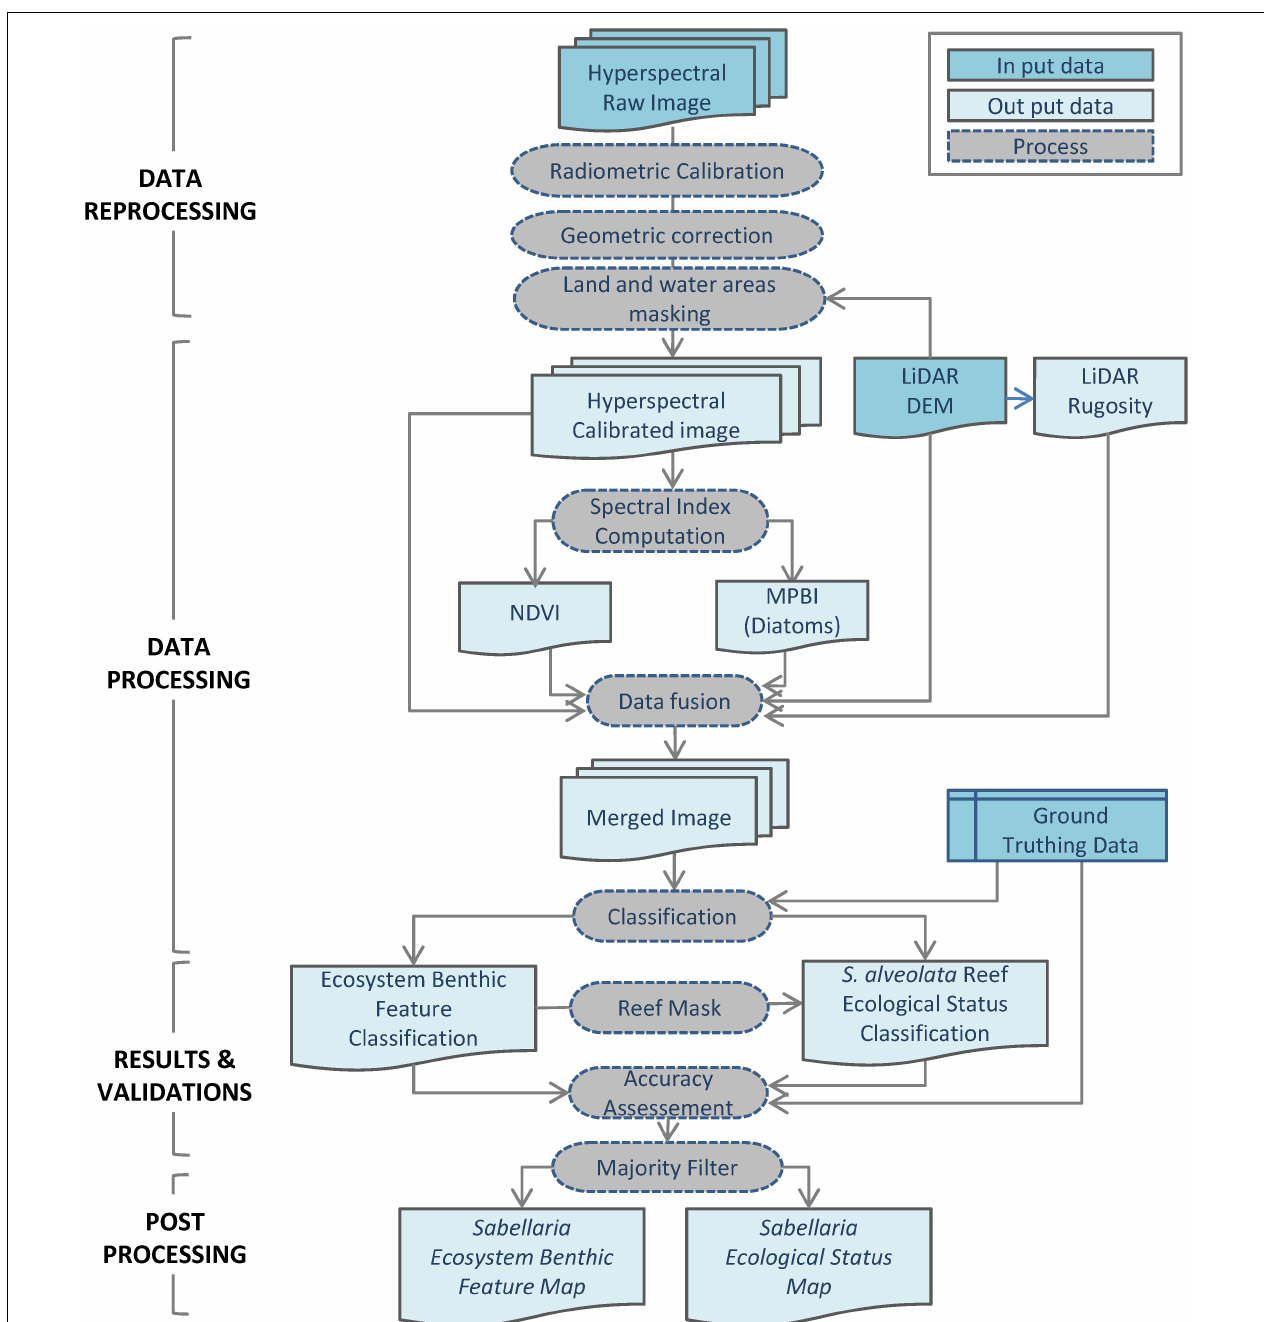
FIGURE 3 | Processing Workflow for Sabellaria alveolata reef ecosystem feature classification and ecological status